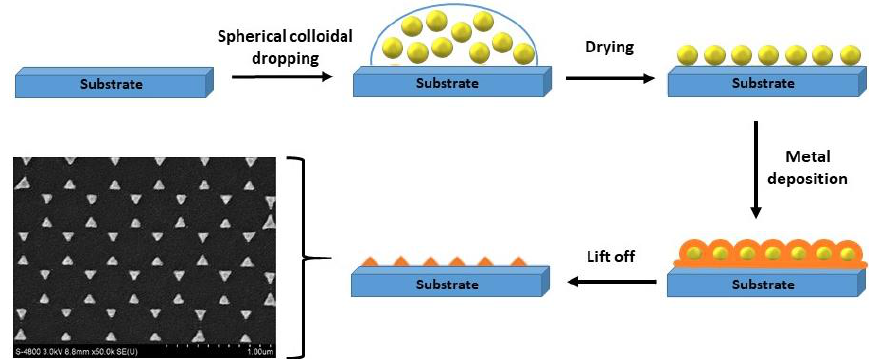
Figure 5. Diagram of the nanosphere lithography (NSL) mechanism. SEM image of topography of the triangular Ag nanoparticles fabricated by NSL. Adapted from [96]. Copyright (2011), publisher and licensee Dove Medical Press